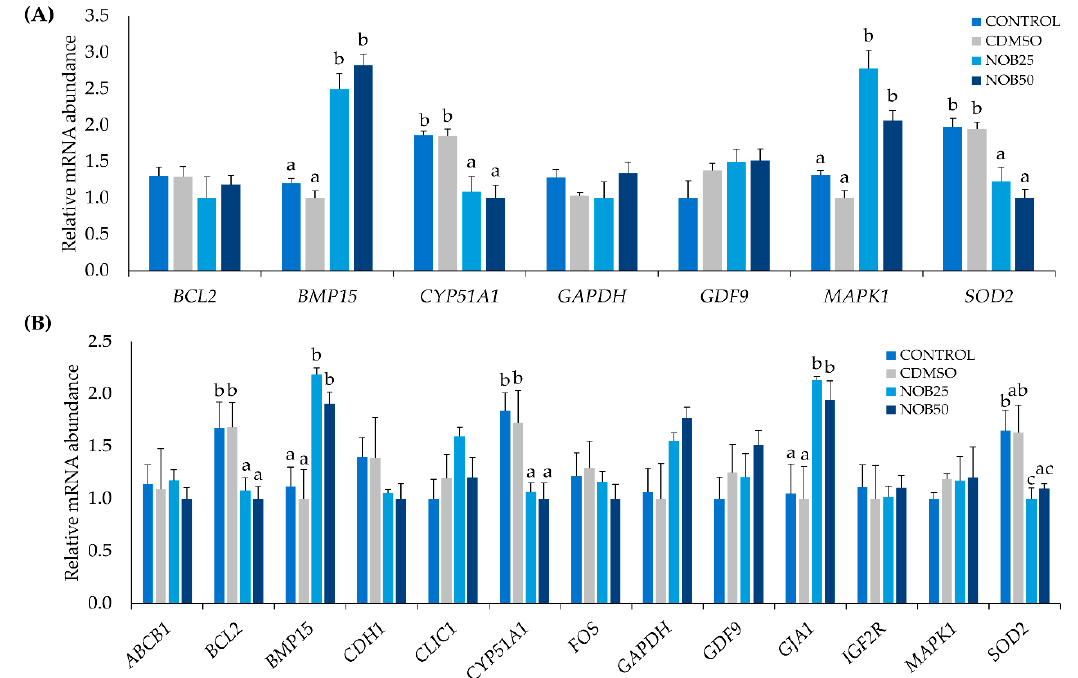
Figure 4. Relative mRNA transcript abundance (normalized against that of the endogenous control H2A histone family member Z ( H2AFZ ) gene and actin beta ( ACTB )). ( A ) Bovine oocytes after in vitro maturation in the presence of nobiletin. ( B ) Bovine cumulus cells (CCs) after in vitro maturation in the presence of nobiletin. ATP-binding cassette subfamily B member 1 ( ABCB1 ), BCL2- apoptosis regulator ( BCL2 ), Bone morphogenetic protein 15 ( BMP15 ), Cadherin 1 ( CDH1 ), Chloride intracellular channel 1 ( CLIC1 ), Cytochrome P450, family 51, subfamily A, polypeptide 1 ( CYP51A1 ), Fos Proto-oncogene, AP-1 transcription factor subunit ( FOS ), Glyceraldehyde-3-phosphate dehydrogenase ( GAPDH ), Growth differentiation factor 9 ( GDF9 ), Gap junction protein alpha 1 ( GJA1 ), Insulin like growth factor 2 receptor ( IGF2R ), Mitogen-activated protein kinase 1 ( MAPK ), Superoxide Dismutase 2, Mitochondrial (former MnSOD) ( SOD2 ). Data are the mean ± SEM. Different letters above columns indicate significant differences in gene expression among the experimental groups ( p < 0.05).